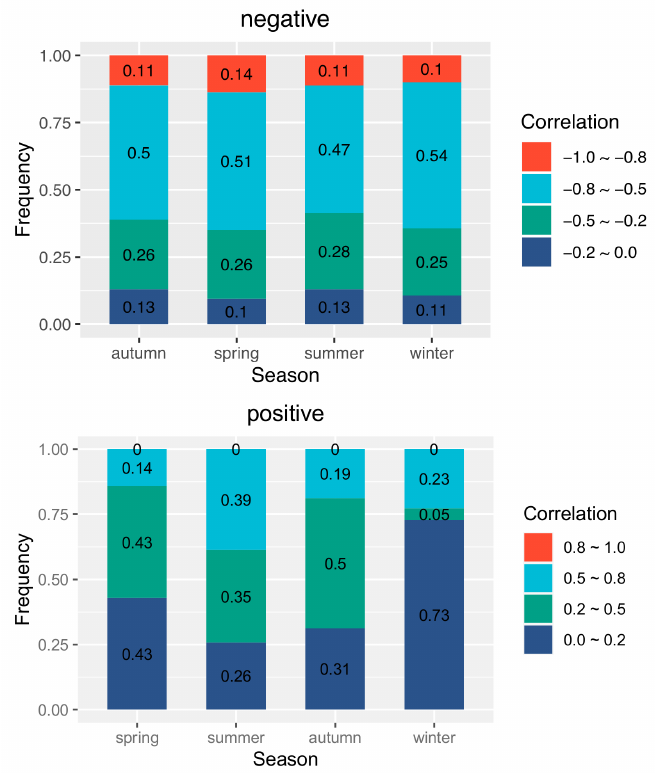
Figure 4. The seasonal variations of the frequency of negative CBO and positive